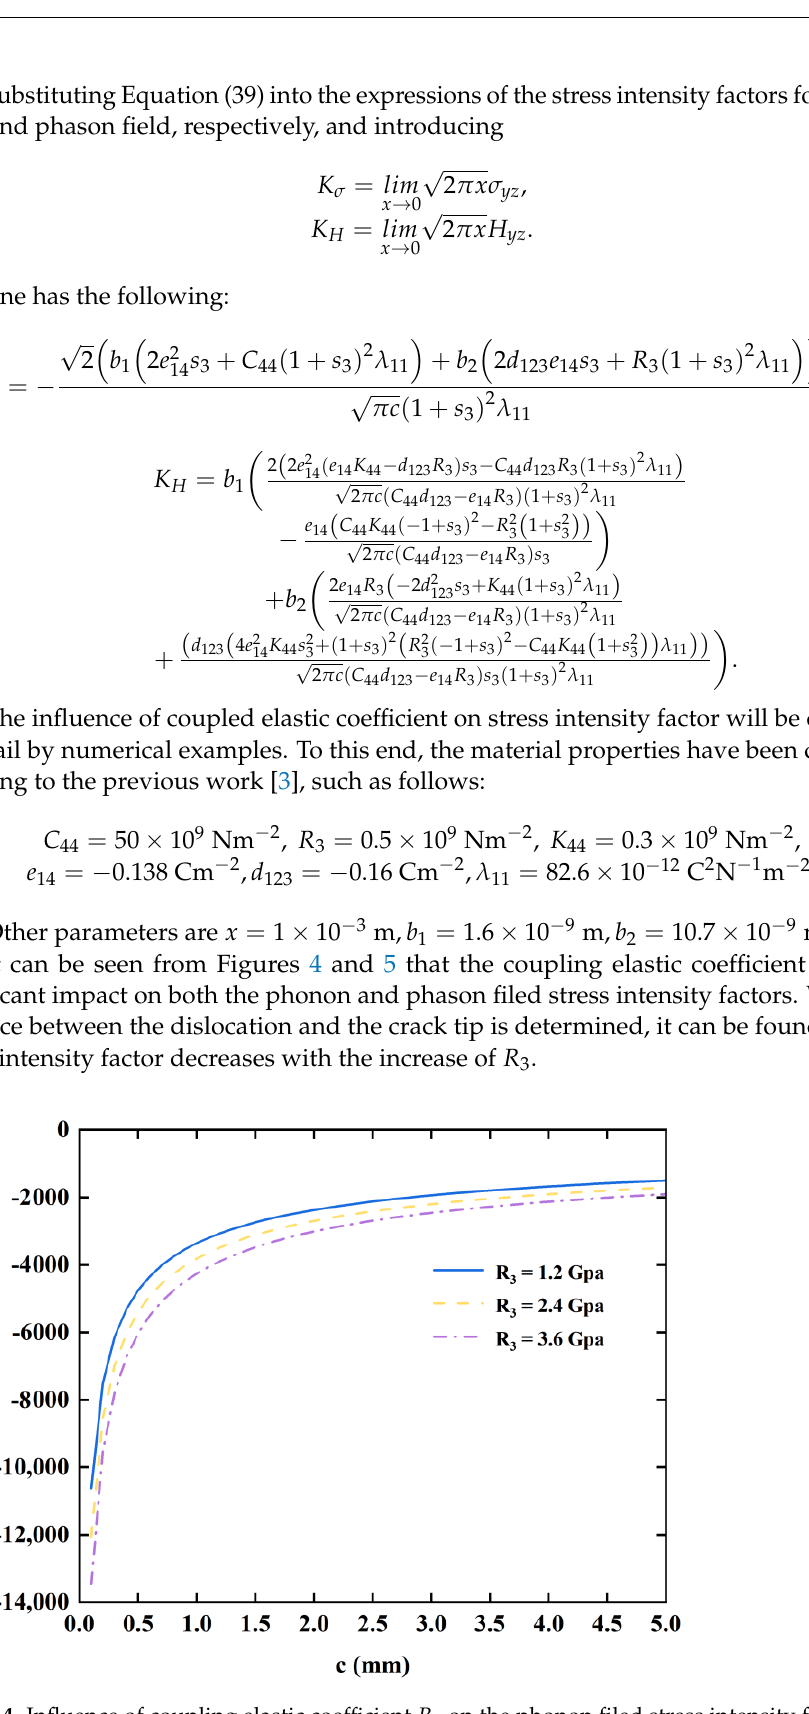
R on the phonon filed stress intensity factor. 3